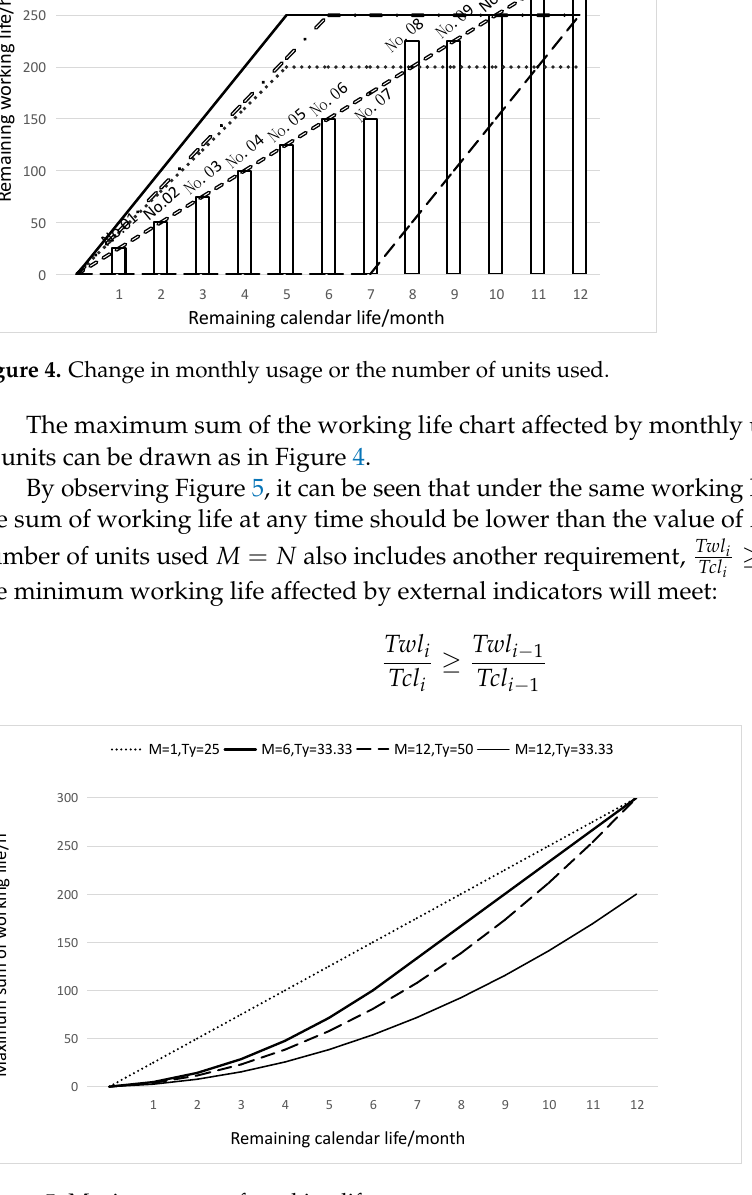
Figure 4. Change in monthly usage or the number of units used.